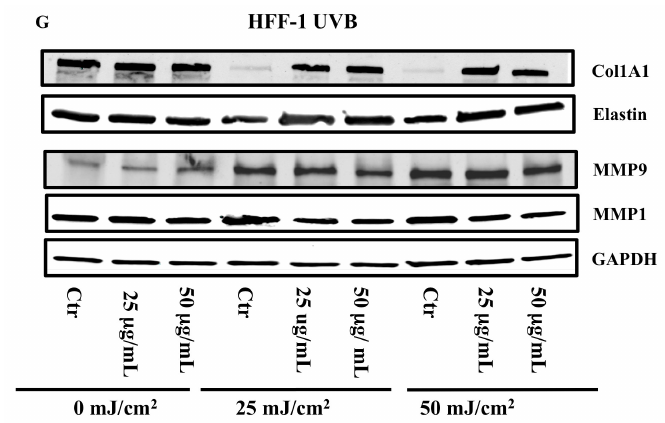
Figure 8. Effects of C. sinensis extract pretreatment (25 and 50 µ g/mL) for 4 h on the regulation of ( A ) mRNA expression of type 1 collagen (COL1A1) and elastin (ELN) and ( B ) mRNA expression of MMP9 and MMP1; protein levels of COL1A1 ( C ), ELN ( D ), MMP1 ( E ), and MPP9 ( F ) after exposure to UVB (25 and 50 mJ/cm 2 ) in HFF1 cells ( G ). Representative immunoblotting image of each protein examined. The data are reported as the mean ± S.D. from two experiments performed in quadruplicates. Dashes to the right of the membrane bands show positions of prestained molecular mass markers. ** Significant vs. untreated control cells: p < 0.01; *** Significant vs. untreated control cells: p < 0.001; # Significant vs. untreated irradiated cells: p ≤ 0.05; ## Significant vs. untreated irradiated cells: p < 0.01.